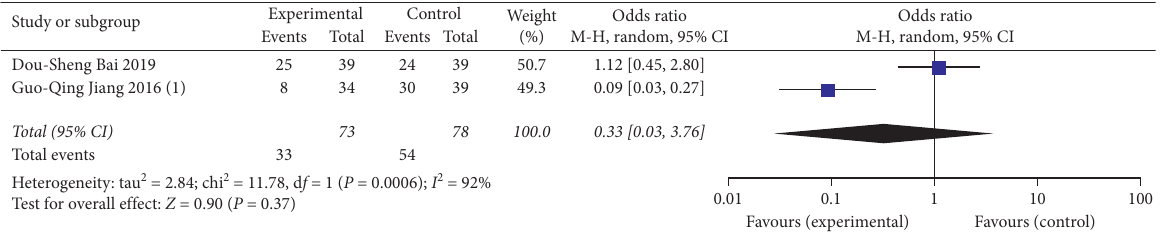
Figure 7: Effect of prophylactic anticoagulation with different